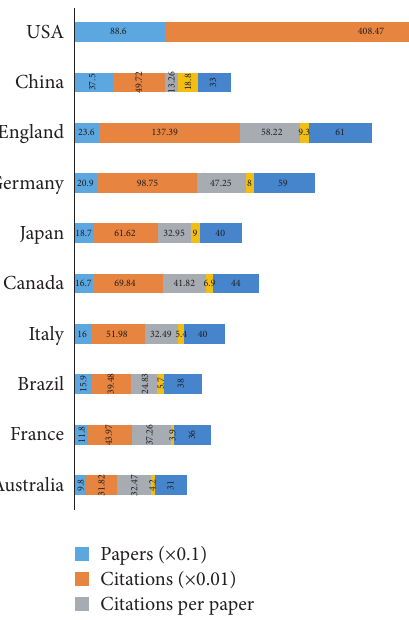
Figure 6: Number of papers, citations, citations per paper, open access papers, and H-index of the top 10 countries.